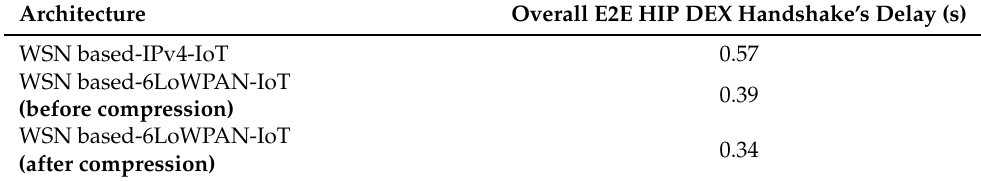
Table 11. Overall E2E delays of handshake packets.